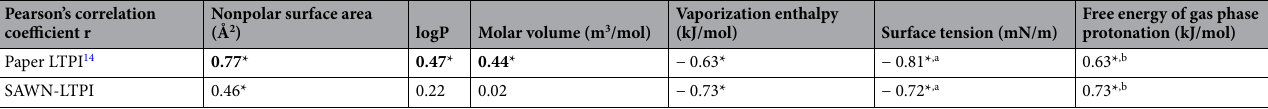
Table 1. Comparison of Pearson’s correlation coefficients r between the log-transformed signal intensity of the investigated target compounds obtained with Paper- 28 and SAWN-LTPI, and their molecular descriptors. Values with large differences are labeled bold. Scatterplots of the raw data are presented in the electronic supplementary material ESM S4. *Significant correlation (p < 0.05). a Spearman’s ρ to meet the precondition of homoscedasticity with SAWN-LTPI; note that the Pearson’s correlation coefficient of regression analysis with the Paper-LTPI response is r = 0.86. b Spearman’s ρ to meet the precondition of homoscedasticity with Paper- LTPI; note that the Pearson’s correlation coefficient of regression analysis with the SAWN-LTPI response is r = 0.71.